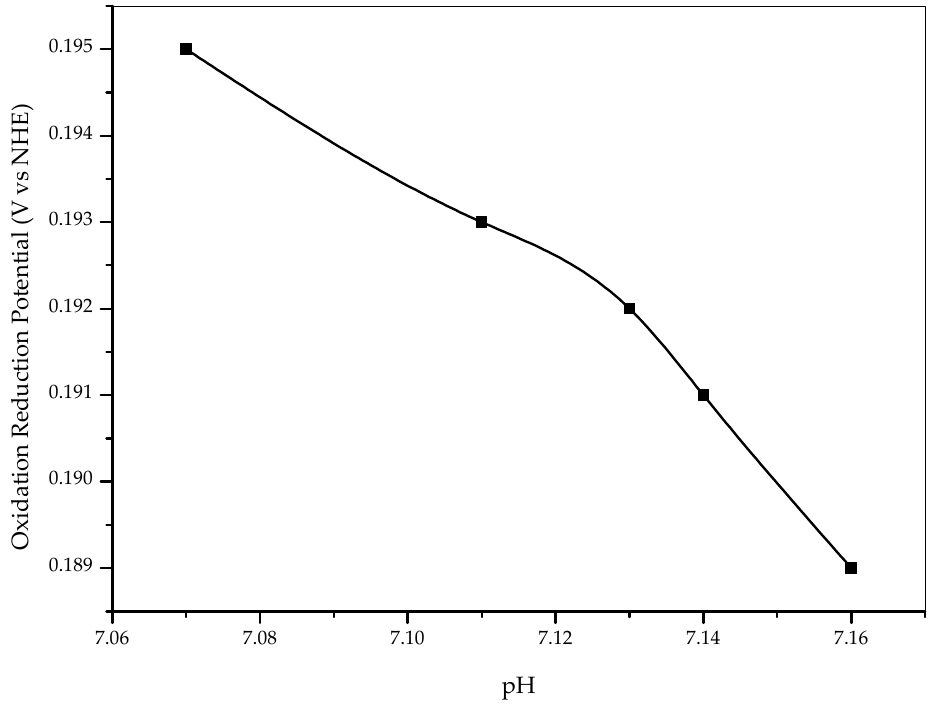
Figure 6. The oxidation-reduction potential of mix solution during the pH changes.